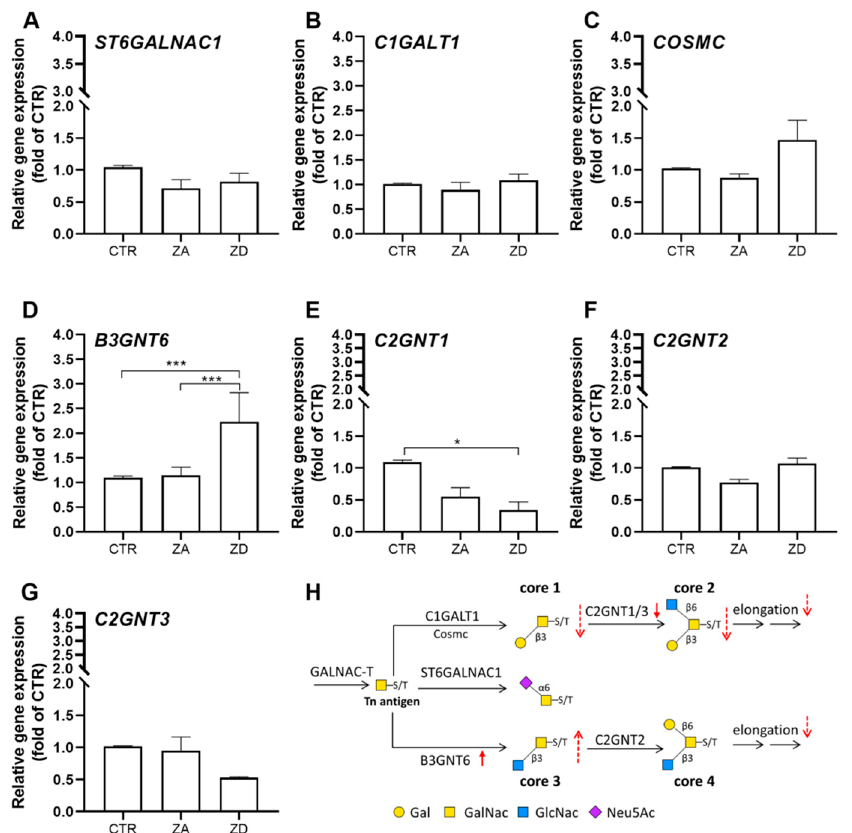
Figure 7. Impact of zinc deficiency on the expression of transferases responsible for the synthesis of core 1-4 O -glycans. ( A – G ) Expression of transferases that determine formation of the core structures 1-4 were analyzed using post-confluent HT-29-MTX cells, cultured in CTR, zinc-adequate (ZA) or -deficient (ZD) medium, respectively. ( H ) Initial steps of glycan biosynthesis, modified from [41], and changes of this process during zinc deficiency are shown (dashed arrows). Monosaccharides are depicted according to the symbol nomenclature for glycans (SNFG) [44]. Changes in gene expression of ST6 N -Acetyl-galactosaminide α -2,6-Sialyltransferase 1 (ST6GALNAC1), core 1 glycoprotein- N -acetylgalactosamine 3- β -galactosyltransferase (C1GALT1), the C1GALT1-specific molecular chaperone (COSMC), β -1,3- N -acetylglucosaminyl-transferase (B3GNT6) and β -1,6- N -acetylglucosaminyltransferase isoforms (C2GNT1, C2GNT2, C2GNT3) in zinc-deprived states are depicted with closed arrows (downward: downregulation; upward: upregulation). Data are presented as means + SEM of three independent experiments. Significant di ff erences are indicated (* p < 0.05; *** p < 0.001; ANOVA with Bonferroni post hoc